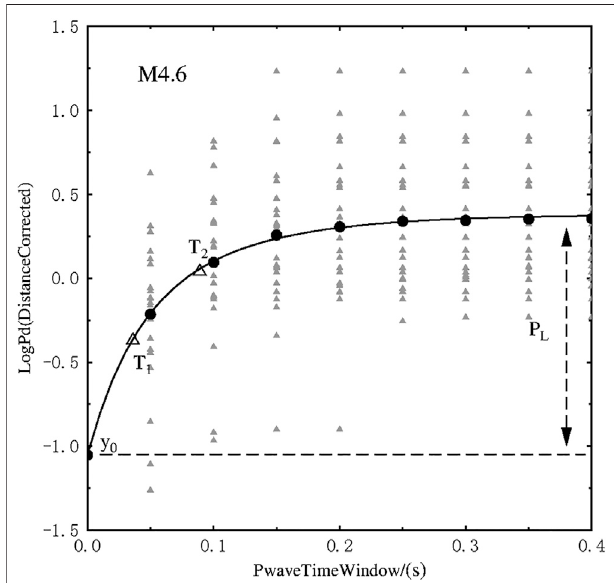
FIGURE 2 | The LPDT curve of M4.6 event and the model parameters. The grey triangles stand for the corrected amplitude Pd C for the available stations at each P-wave time window, then the circle represents the average Pd C value of all these stations. Our exponential fi t model is shown in black line. The time parameters T 1 and T 2 are shown in the empty